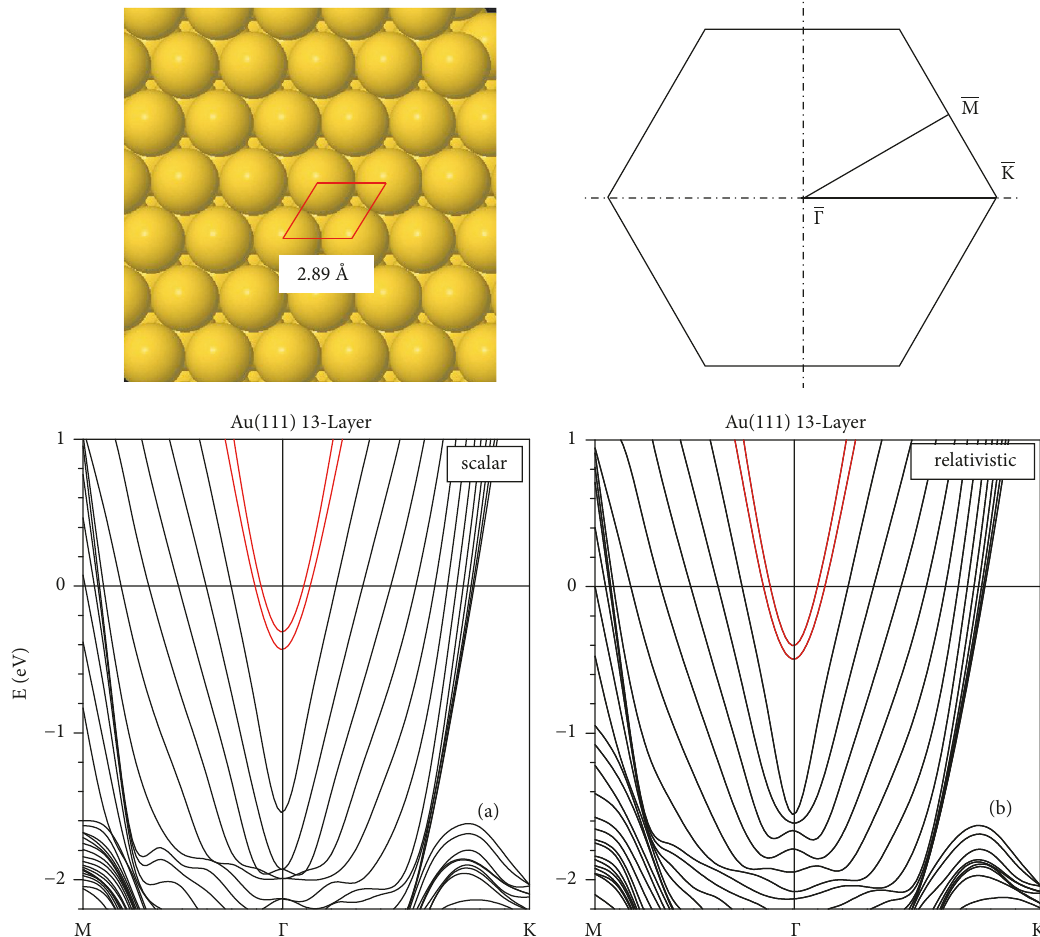
Figure 1: The band structure of Au(111) calculated for 13-layer film in the semirelativistic (a) and full relativistic (b) approximations. The surface bands are marked red.